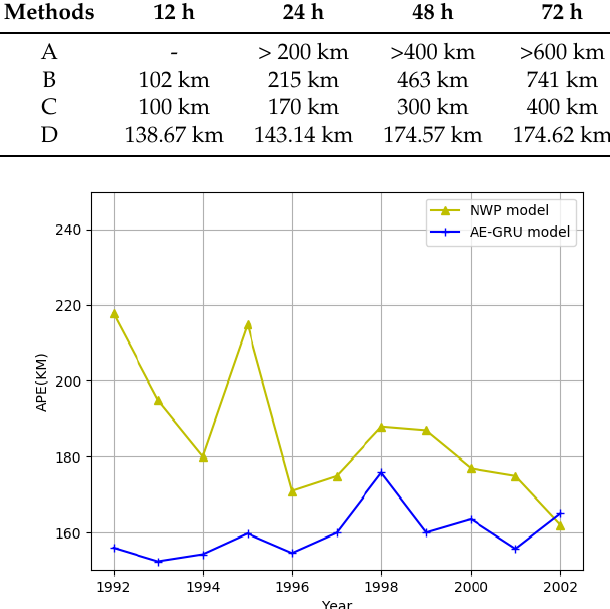
Table 4. Twelve hour, 24 h, 48 h, and 72 h forecast results of AE-GRU and Methods A, B, and C.